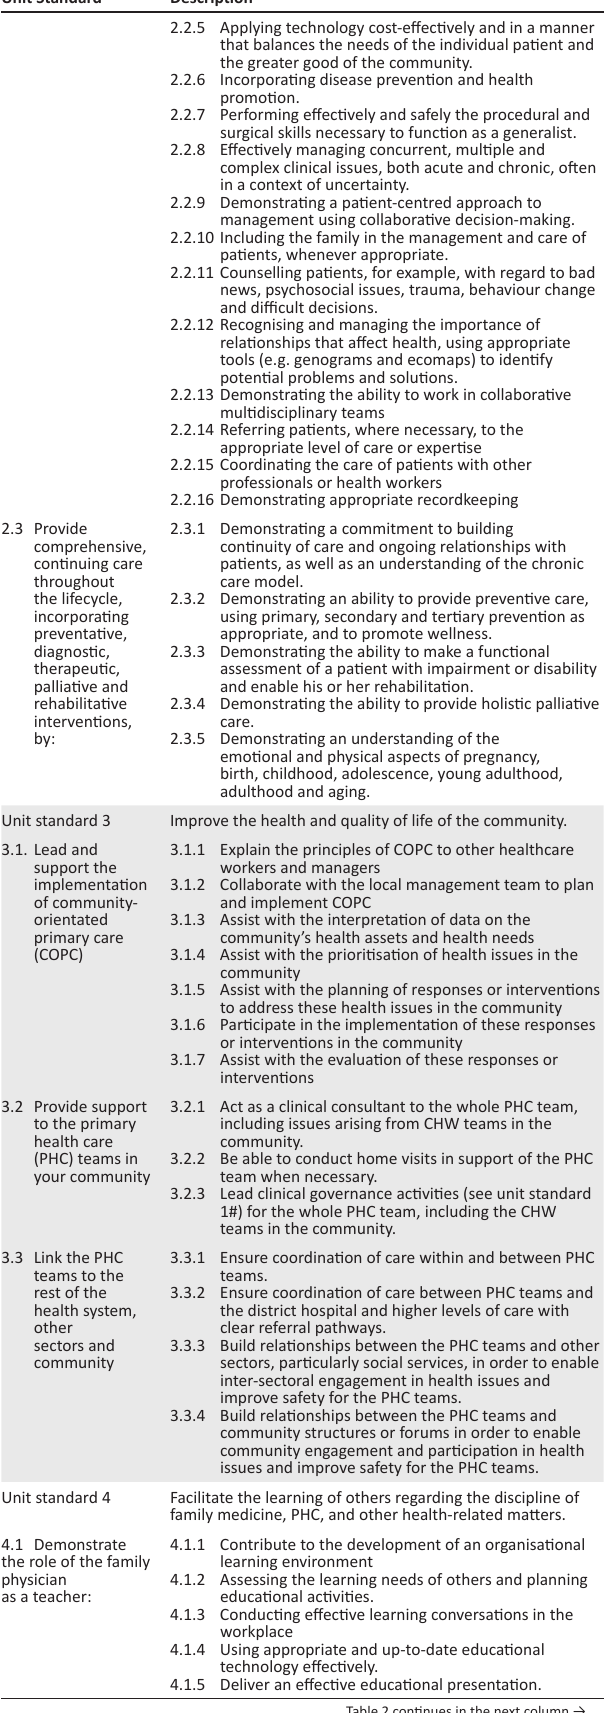
TABLE 2 (Continues...): Programmatic learning outcomes. Unit